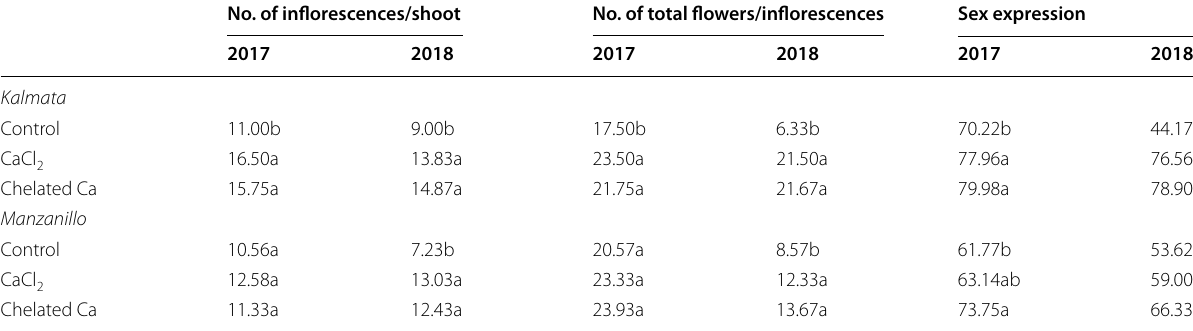
Table 1 Effect of foliar spray with some calcium sources on flowering of olive Kalmata and Manzanillo cultivars No. of inflorescences/shoot No. of total flowers/inflorescences Sex expression